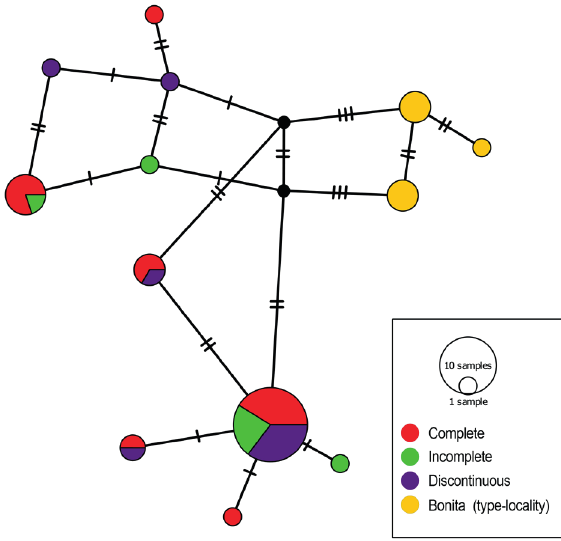
Figure 2 - Median-joining haplotype network from samples of Moenkhausia bonita from the upper Paraná River floodplain with different developmental levels of the lateral line, as well as samples from the Baía Bonita, Mato Grosso do Sul State, with complete lateral